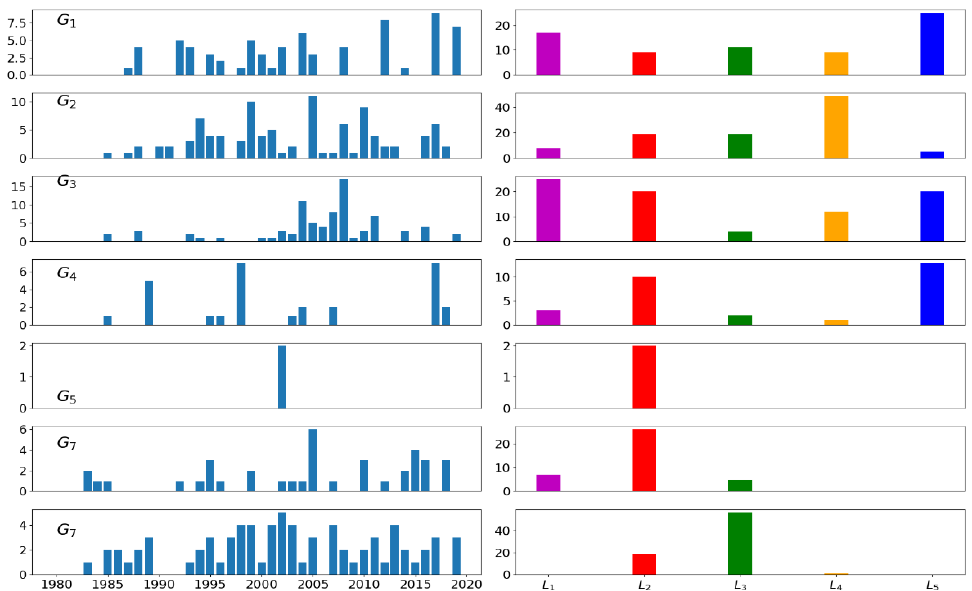
Figure 7. Landfalling counts of TCs formed in each genesis region from 1980 to 2019 ( left panel ) and frequency of landfalling in each landfall region of each genesis region ( right panel ).